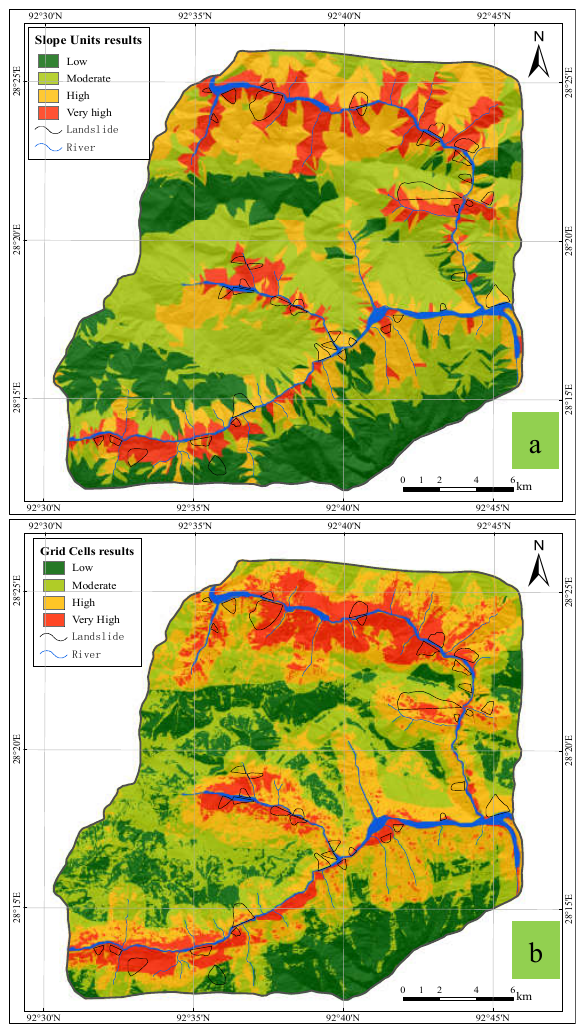
Figure 8. Landslide susceptibility map results using ( a ) slope units and ( b ) grid cells.